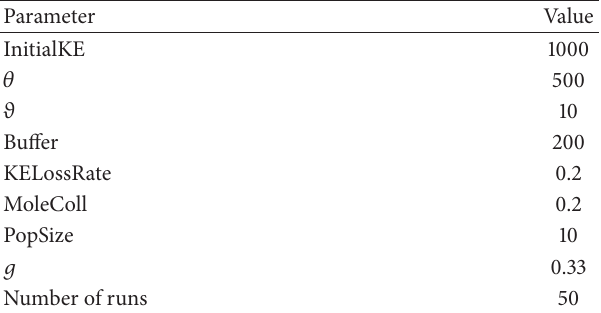
Table 3: Configuration parameters for the simulation of TMSCRO.